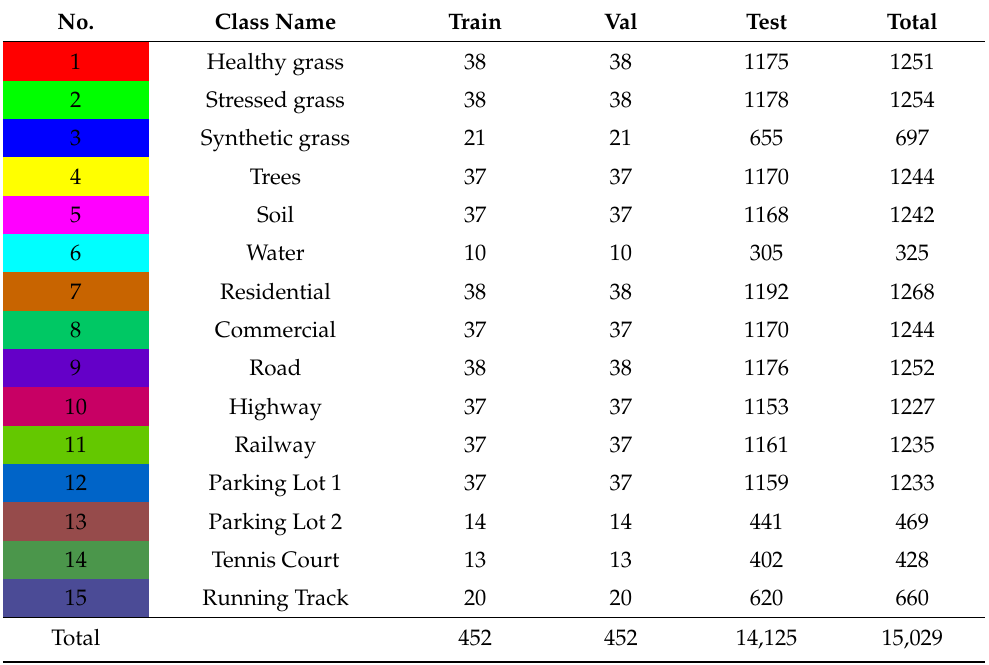
Table 4. Training validation and testing sample numbers in